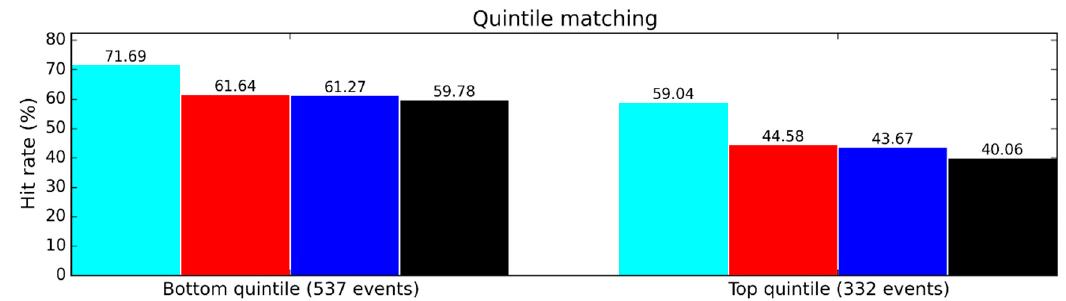
Figure 2. Point-based comparison from January 2001 to December 2018 using Papua New Guinea (PNG) weather stations as truth. Mean average error (MAE), normalised mean average error, and bottom and top quintile comparisons are displayed.